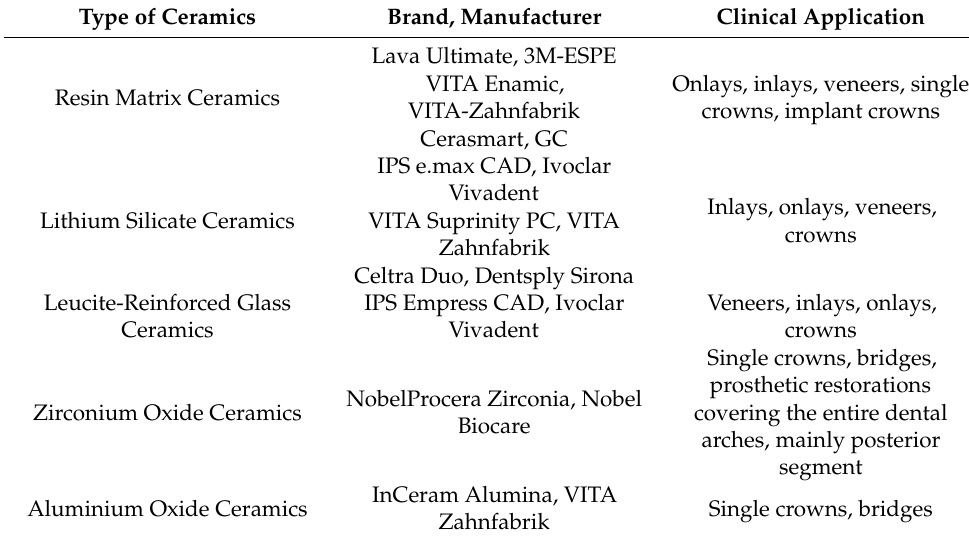
Table 1. Examples of commercial ceramic CAD/CAM material with its